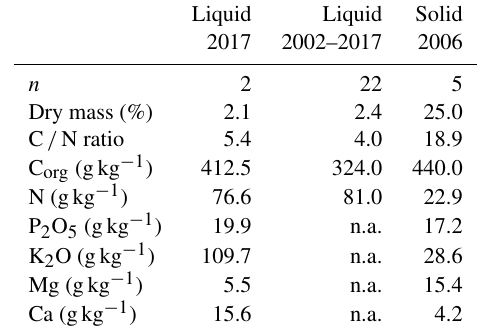
Figure C1. Average soil carbon (a) and nitrogen (b) densities ( ρ C and ρ N , respectively) in five different soil layers and on two days be- fore and three days after the application of liquid manure in 2017. Standard errors are shown as error bars. The grey dashed line in- dicates the day of manure application. The number of samples ( n ) included in the averages is given in the legend.